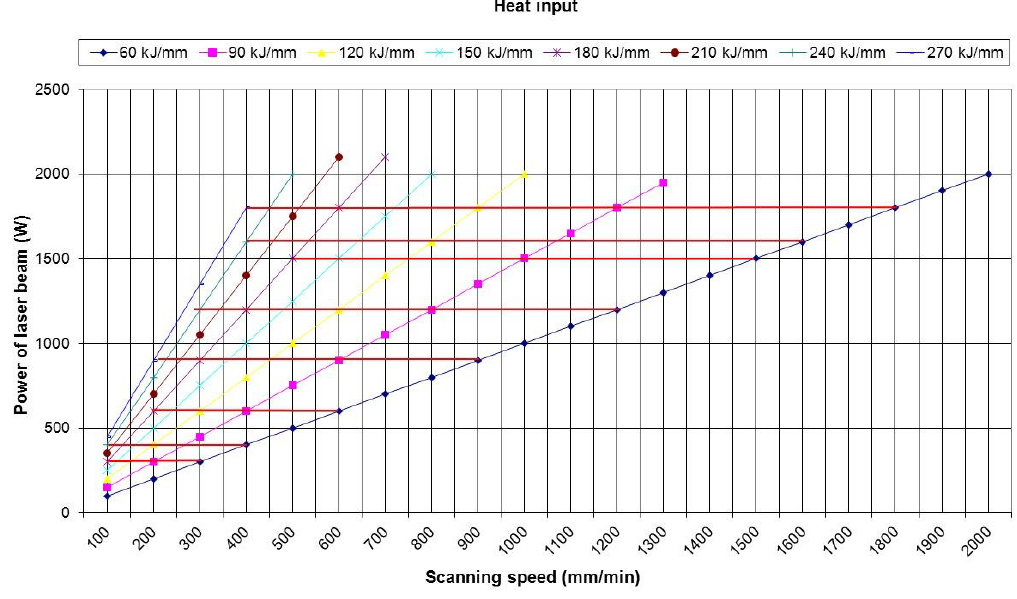
Figure 5. Graphic illustration of the relationship between laser power and scanning speed for a constant heat